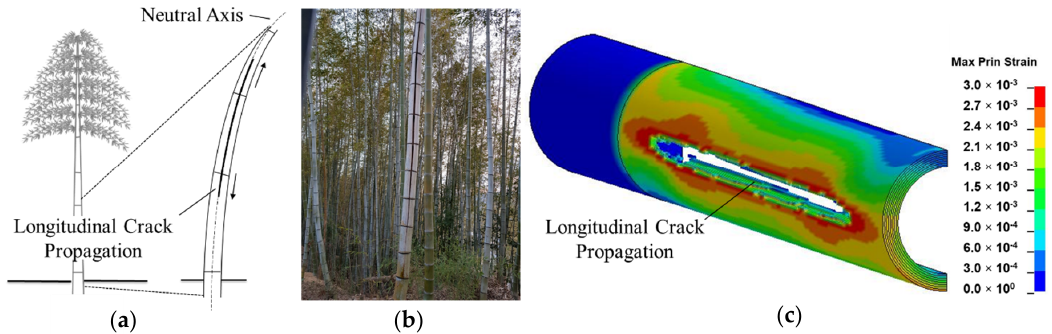
Figure 15. Failure mechanisms of bamboo in shear: ( a ) schematic representation of longitudinal split at culm neutral axis; ( b ) longitudinal split in natural bamboo; ( c ) fringe plot of maximum principal strain of hollow-inhomogeneous model in shear